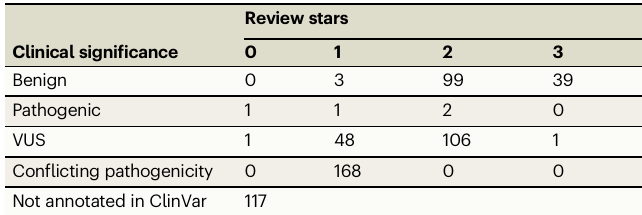
Table 3 | ClinVar clinical signi fi cance of common variants of the Estonian